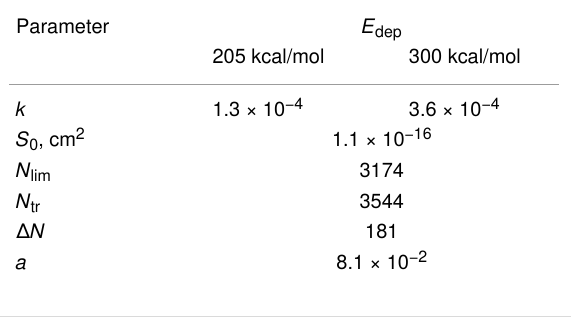
confirms that the variable parameters defining the growth rate of the clusters do not depend on E dep .